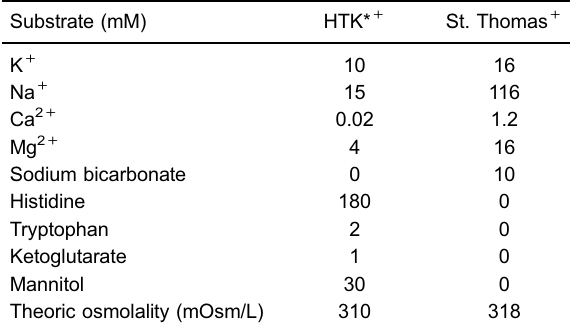
Table 1. Composition of histidine-tryptophan-ketoglutarate (HTK) and St. Thomas ’ cardioplegic solutions. Substrate (mM) HTK*